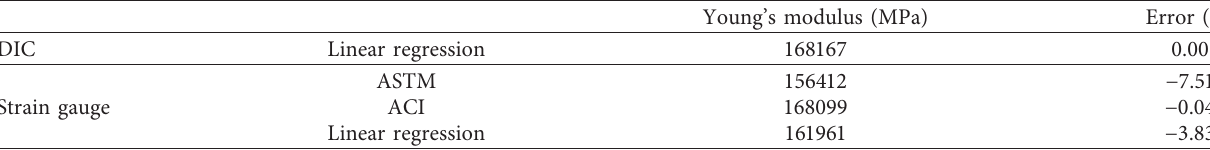
Table 6: Young’s modulus comparison of